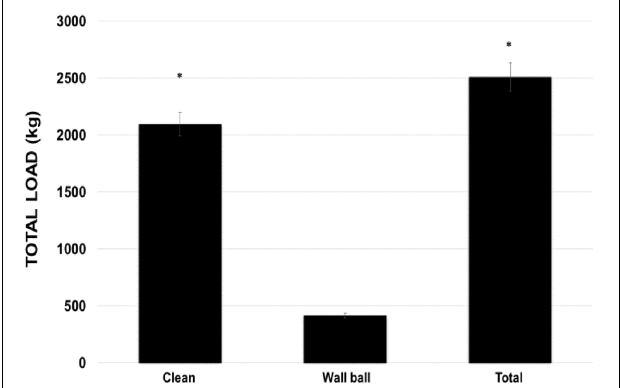
FIGURE 4 | Total load volume used during the WOD (workout of the day) for the clean and wall ball exercises, and the total load of the training session. ∗ p < 0.01 vs wall ball exercise. ANOVA ( F ) = 32.564, p < 0.05.